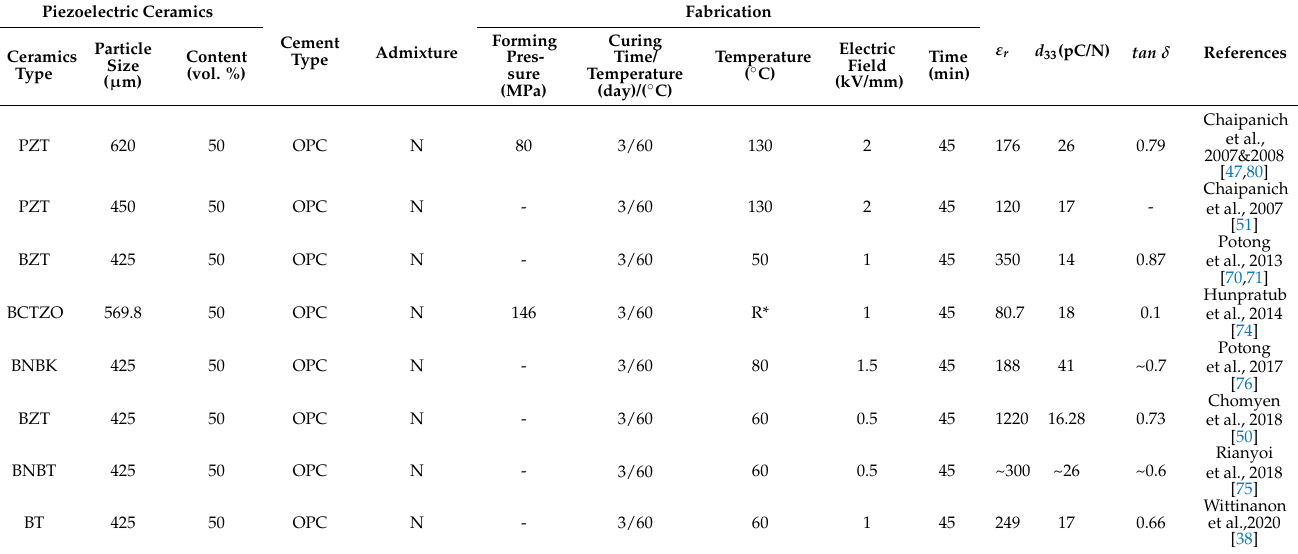
Figure 7. Atomic force microscopy (AFM) for non-polarized and polarized cement. Reprinted with permission from ref. [79]. Copyright 2019 Elsevier. Table 6. Performance and polarization parameters of CPCs with different ceramic